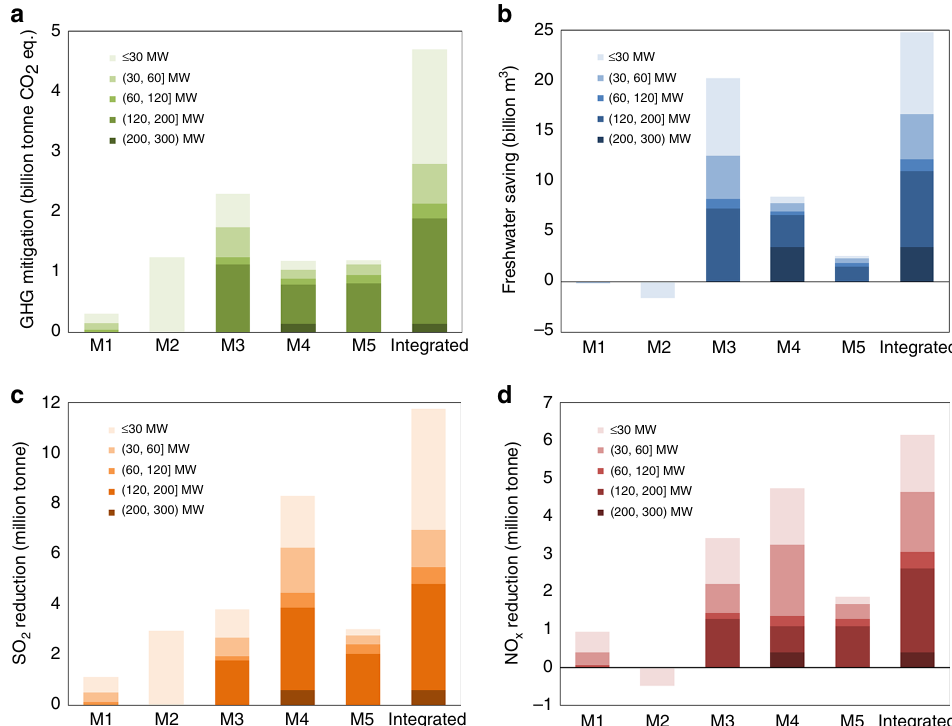
Fig. 4 Environmental bene fi ts of GHG mitigation scenarios decomposed by different-sized units. a – d present GHG mitigation potential, freshwater saving, SO2 emission reduction, and NOx emission reduction in M1 – M5 and Integrated scenarios. M1, retro fi tting coal- fi red boilers to natural gas (NG)- fi red boilers; M2, replacing coal- fi red boilers with MSW incinerators; M3, retro fi tting extraction-condensing or pure-condensing turbines to back-pressure turbines; M4, replacing small-capacity coal- fi red units with large-capacity coal- fi red units; and M5, replacing small-capacity coal- fi red units with large- capacity natural gas combined cycle (NGCC) units; Integrated scenario, implementing M1 – M5 jointly. Source data are provided as a Source Data fi le. Table 2 Direct and indirect environmental bene fi ts in GHG mitigation scenarios.